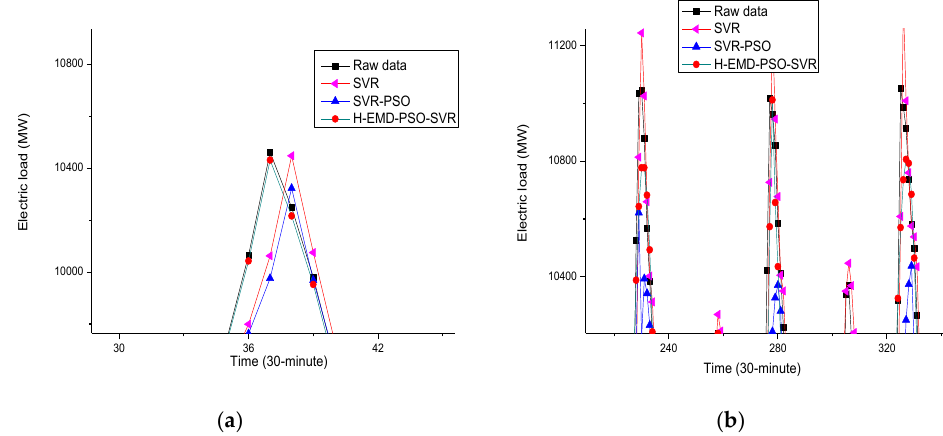
Figure 7. The local enlargement (peak) comparison of the H-EMD-SVR-PSO model and other models. ( a ) The small sample; ( b ) The large sample.